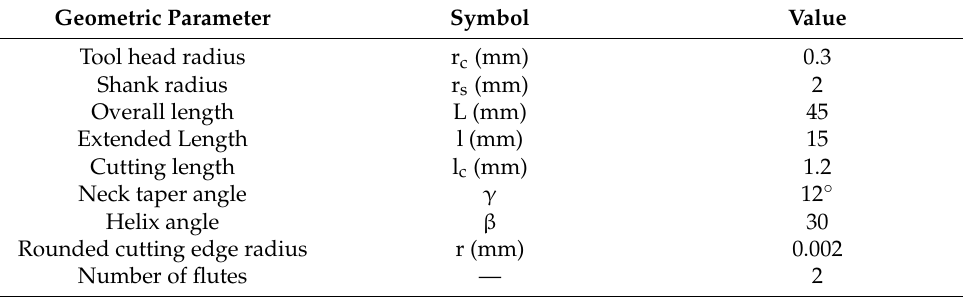
Table 1. Geometric parameters of the micro-milling tool.